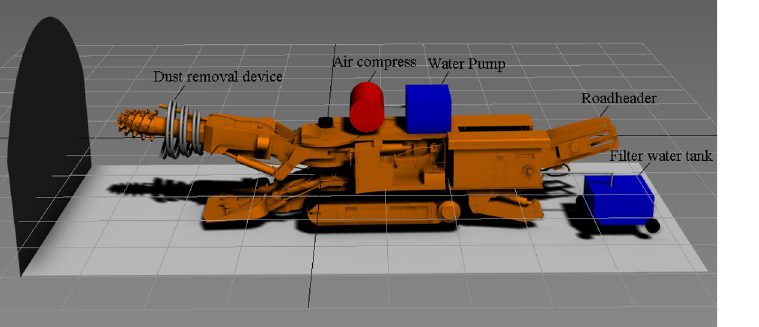
Fig 1. 3D design drawing of the multilayer spiral fog curtain dust removal device.